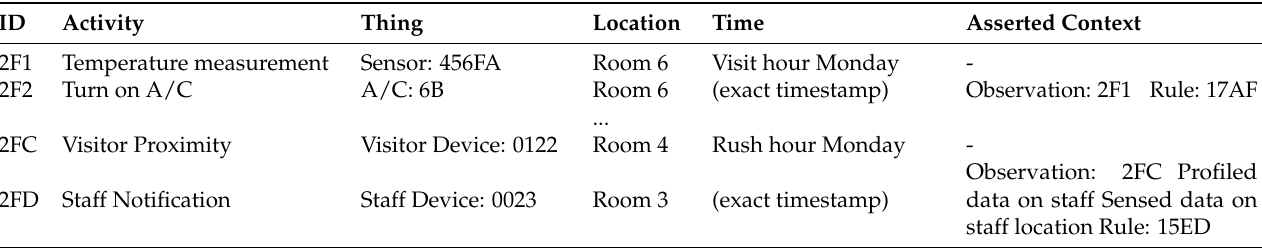
Table 5. Examples of observation